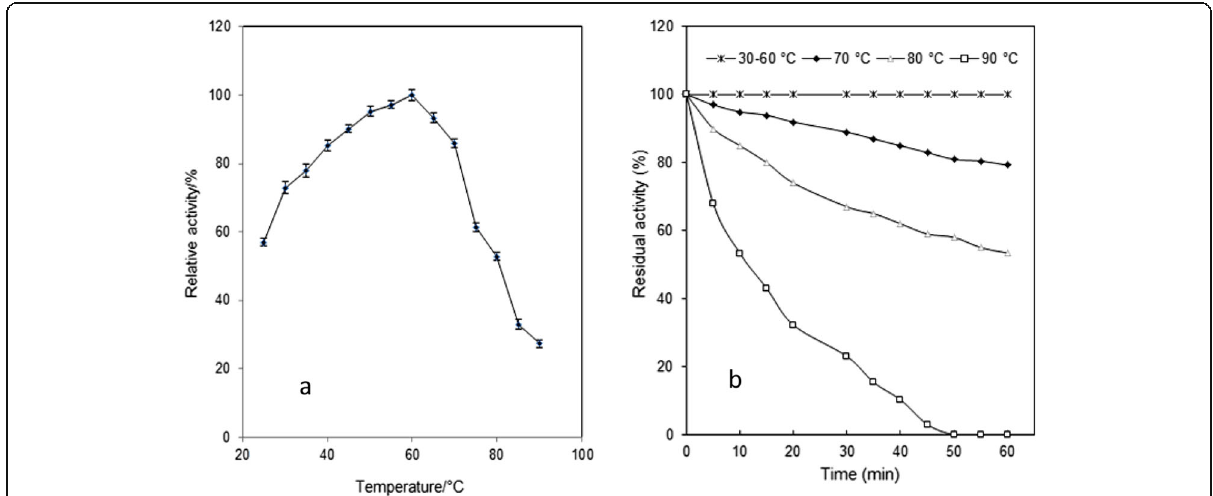
Fig. 4 Effect of temperature on activity and stability of Aspergillus sp. DHE7 β -glucosidase: a Effect of temperature was determined by assaying the enzyme at different temperatures ranging from 25 to 90 °C, at pH 5.0 (0.05 M Na-citrate) against p -NPG as substrate. b Thermal stability behavior of Aspergillus sp. DHE7 β -glucosidase was evaluated by pre-incubating of the purified enzyme at different temperatures (pH 6.0, 30 – 90